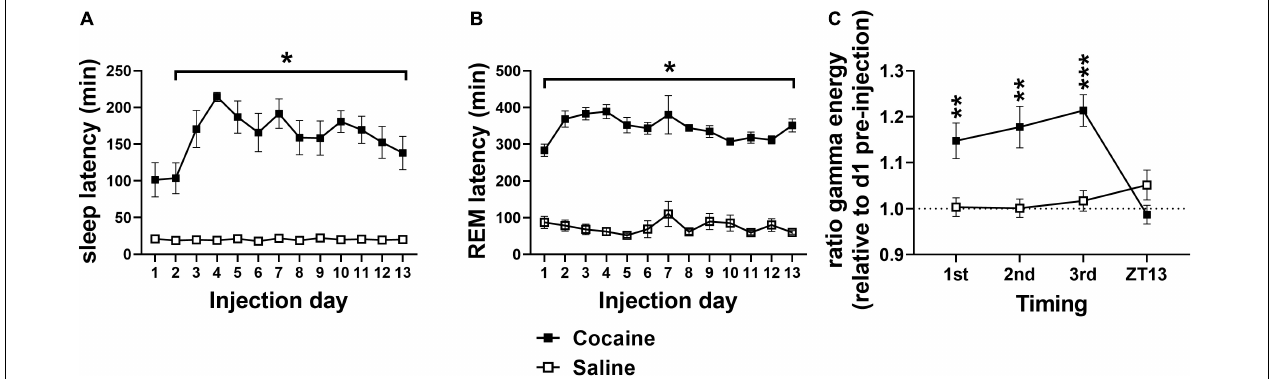
FIGURE 2 | (A) Cocaine increased SL compared to saline with significant pairwise comparison effects on days 2–13 and a trend toward significance difference on day 1. (B) Cocaine increased REML compared to saline on all days. (C) Relative gamma energy (ratio to pre-injection waking gamma energy) increased following each of the three cocaine injections compared to saline, while gamma energy early in the dark phase (ZT13) was not significantly different between groups. Cocaine n = 10 [ (A,B) one mouse missing value on day 7], saline n = 9 [ (A,B) two mice missing values on day 7]. Asterisks indicate a significant difference between groups and lines indicate the days over which the group difference occurs. P and F values are given in Table 1 and statistics for all pairwise comparisons with significant difference or trends toward significance are given in Supplementary Table 1 .